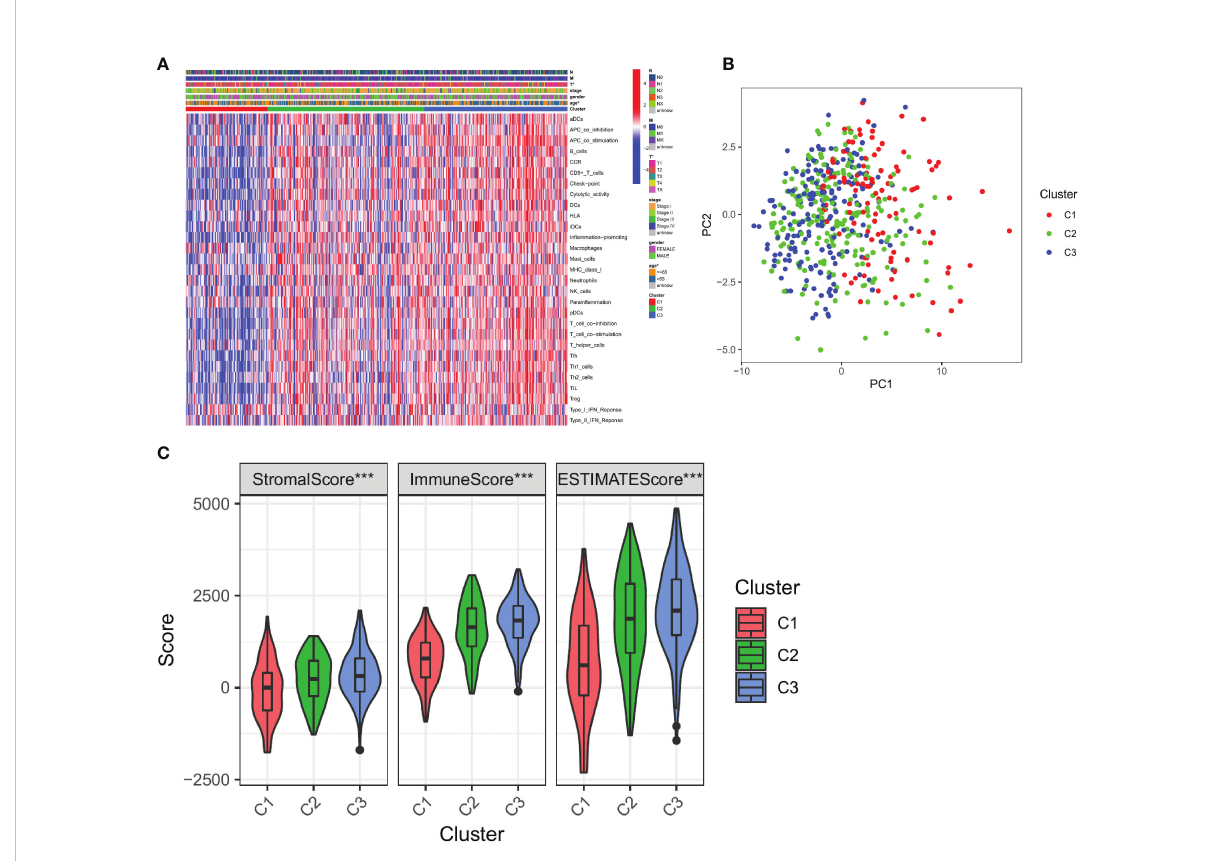
FIGURE 2 Correlation between immune-based subtypes of LUAD and clinical characteristics. (A) Correlation between the expression of 29 immune signature genes and clinical characteristics in three clusters; (B) PCA analysis of three clusters; (C) Immune in fi ltration assessment in three clusters. *, P < 0.05 and ***, P <